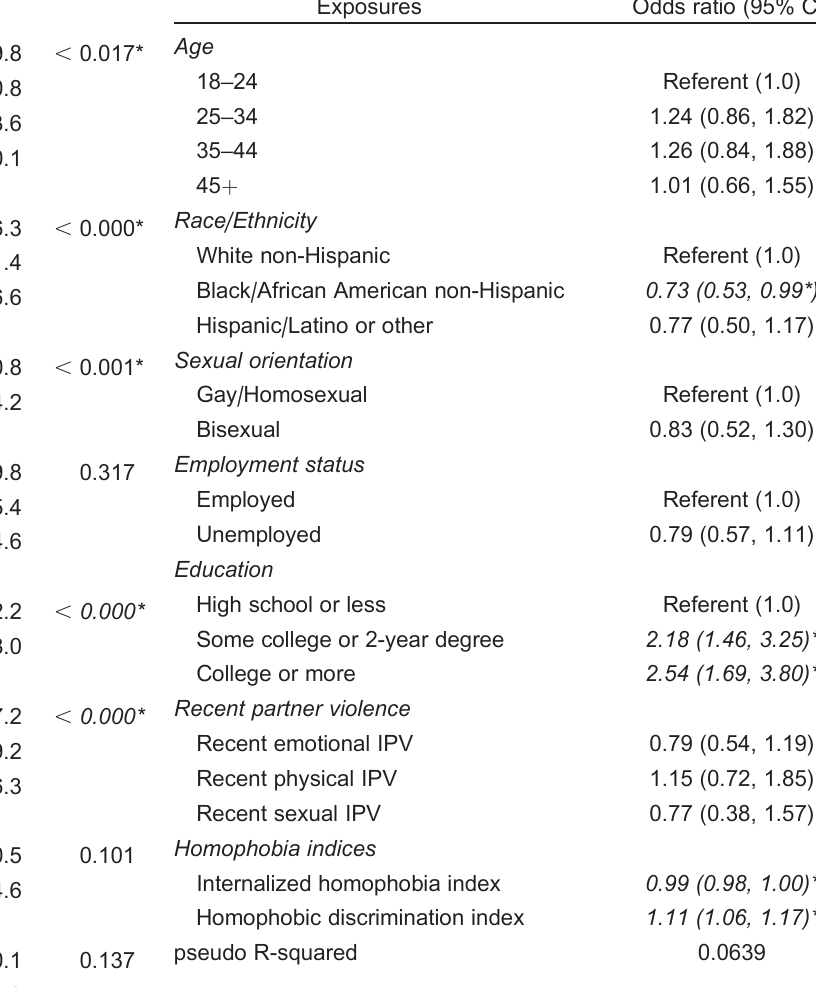
Table 4. Bivariate analysis, percentages of respondents indicating that the police would be less helpful to a gay/bisexual male victim of intimate partner violence (IPV) than to a heterosexual female victim of IPV and results of chi-square testing. * Significant